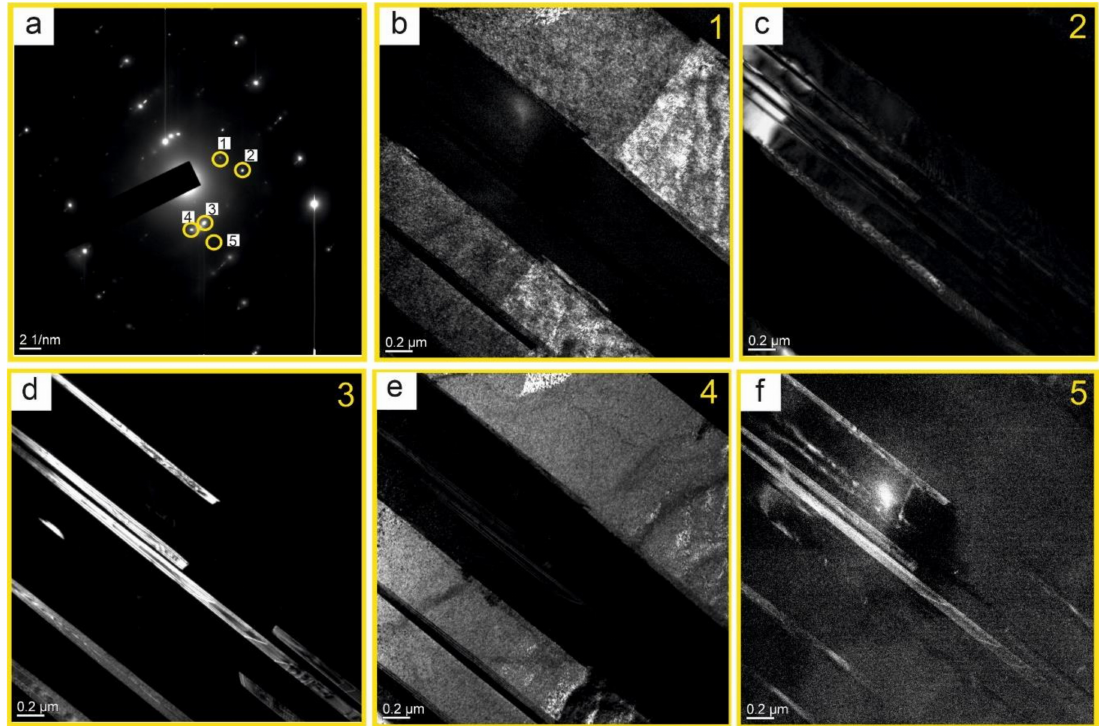
Figure 8. SAED pattern ( a ) of the Ti-Al-Sc alloy to the bright image, and TEM-dark images in the relevant reflexes (1) — a , (2) — b , (3) — c , (4)— d , (5)— e , (6)— f